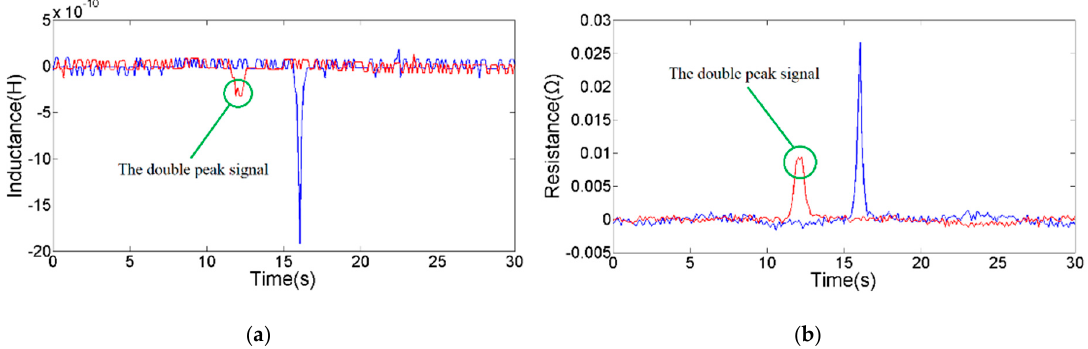
Figure 4. The comparison of experimental results; the blue line is the signal of the sensing unit, and the red line is the signal of the reference unit: ( a ) inductance detection signal of 124 μ m copper particle; ( b ) resistance detection signal of 124 μ m copper particle.